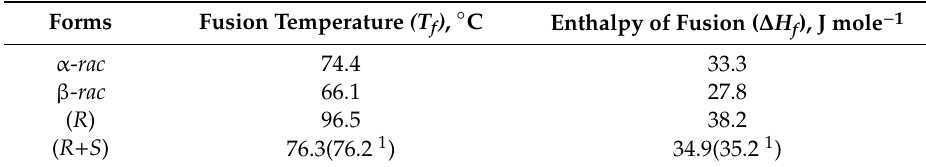
Figure 3. DSC traces of an equilibrium racemic sample identified as a conglomerate (red curve), a racemic sample obtained by crystallization from melt at 72 °C (violet curve), and crystallization from melt upon rapid cooling to 20 °C (olive curve). Sample weight ~ 8 mg.